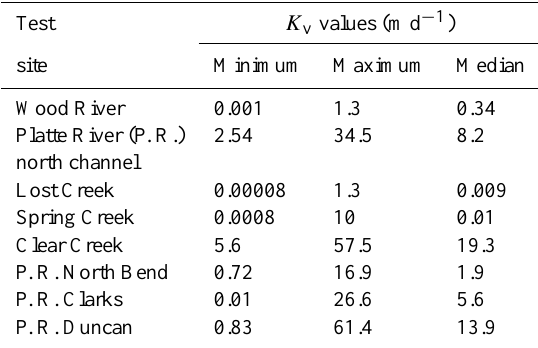
Table 4. Maximum, minimum, and median values of K v from the top five sediment cores at each test